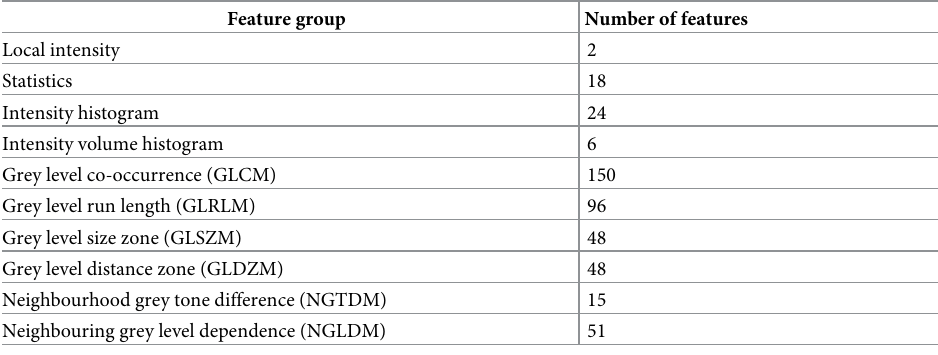
Table 1. Feature groups with the number of features per